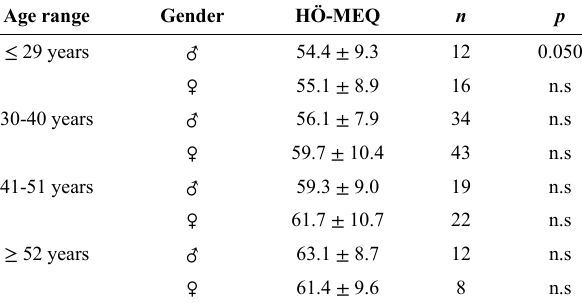
Table 3 - Stratification of HÖ-MEQ scores by gender and age range. Age range